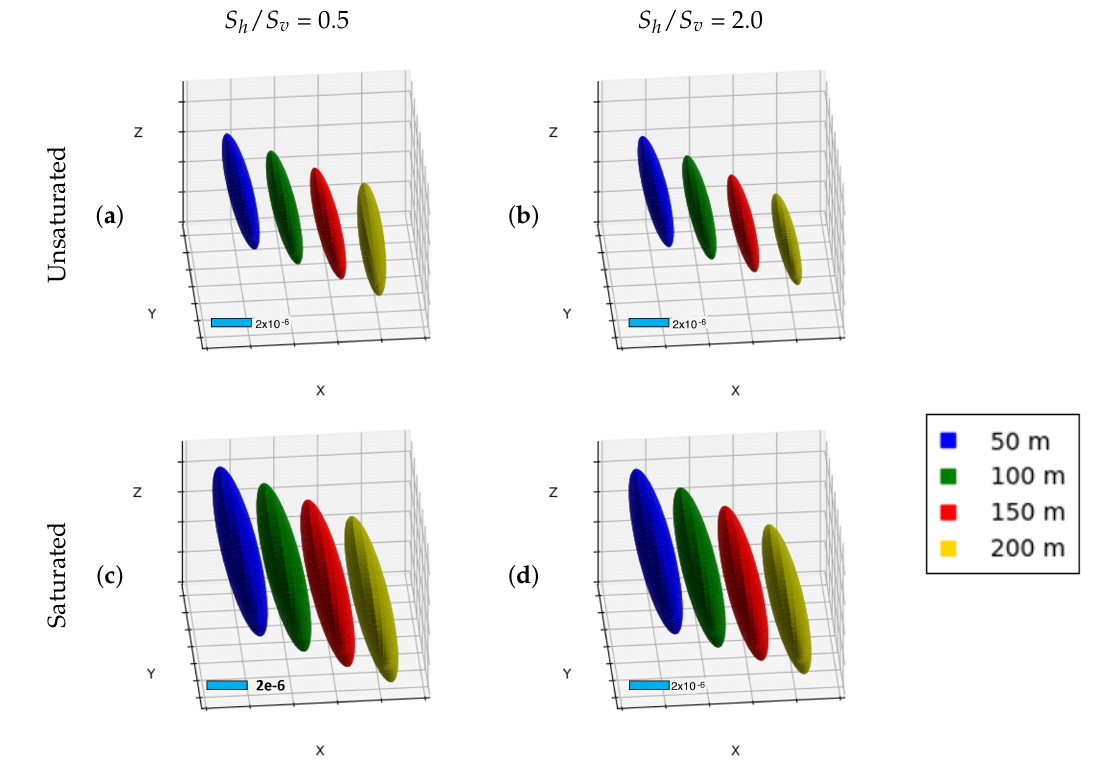
Figure 2. The permeability tensors at depths of 50 m, 100 m, 150 m and 200 m plotted as ellipsoids. There is a noticeable change in the permeability magnitude and orientation under unsaturated conditions under different depths as well as between in situ stress ratios of 0.5 ( a ) and 2.0 ( b ). There is a small permeability difference under saturated conditions between in situ stress ratios of 0.5 ( c ) and 2.0 ( d ). The length of the scale represents a permeability of 2 × 10 − 6 m 2